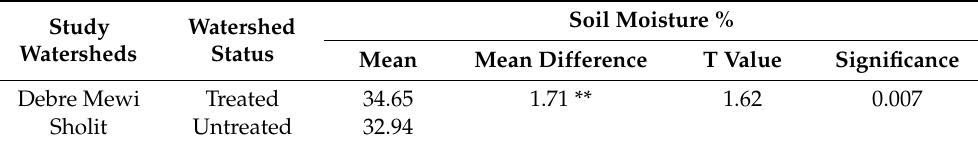
Table 3. Effects of SWC practice on soil moisture in treated and untreated watersheds. Study Watersheds